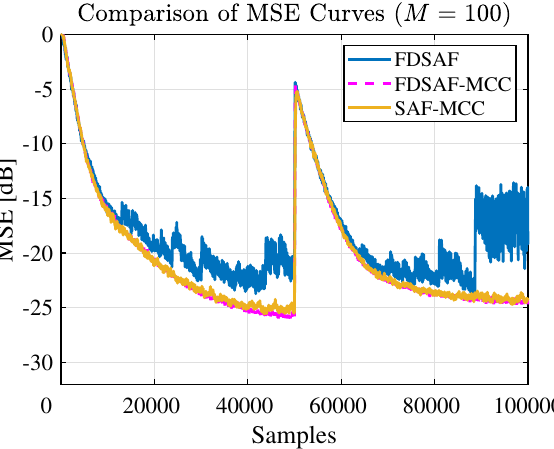
Figure 7. Experiment 1: Comparison of MSE curves of FDSAF, FDSAF-MCC, and SAF-MCC algorithms under impulsive noise and a sudden change.